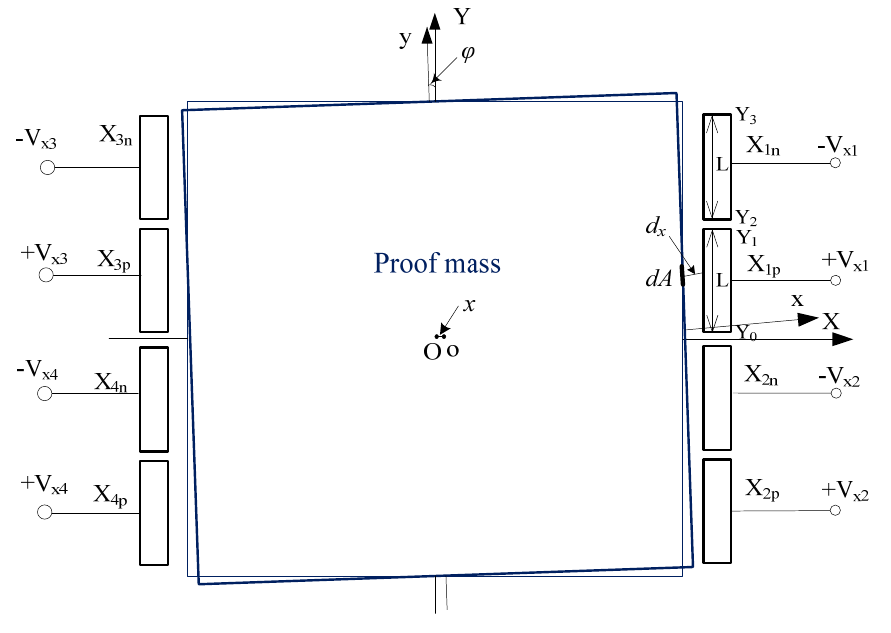
Figure 2. Structural parameters of the accelerometer along X-axis